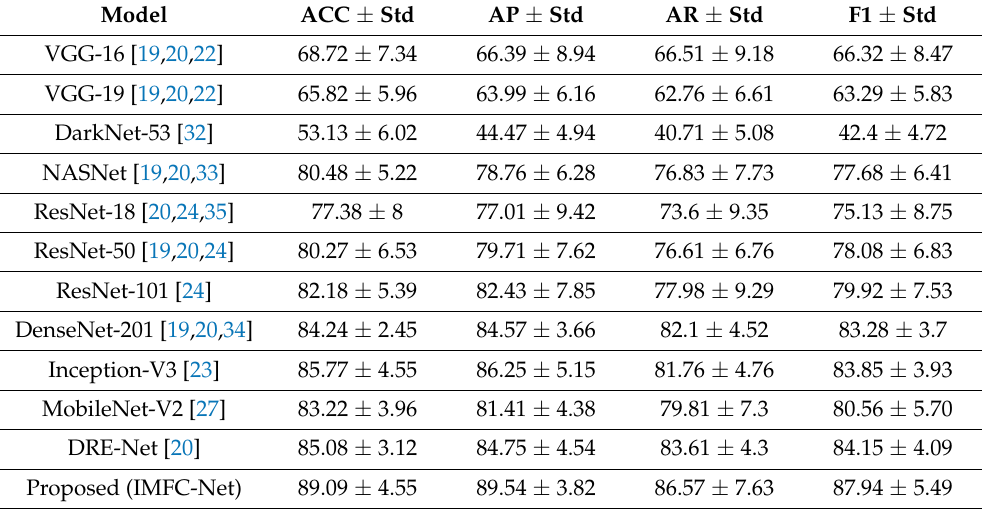
Table 4. Comparative performance analysis of the average results of ten-fold cross-validation between the state-of-the-art and proposed models using rotational invariant augmentation (RIA) [20] for the shoulder implant dataset. (ACC: accuracy, AP: average precision, AR: average recall, F1: F1.score, Std: standard deviation, unit: